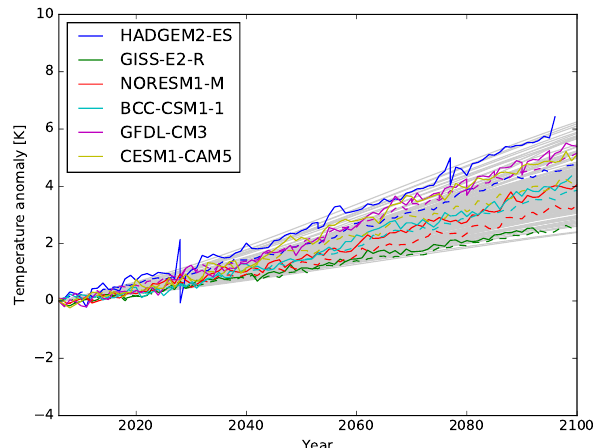
Figure 4. An example of the fit of Eq. (2) (red line) to daily maximum surface temperature anomalies (blue) obtained from the NorESM1-M RCM simulation under the RCP8.5 GHG emissions scenario at Alexandra, New Zealand (45.249 ◦ S, 169.396 ◦ E). Solid line represents the zero line (no